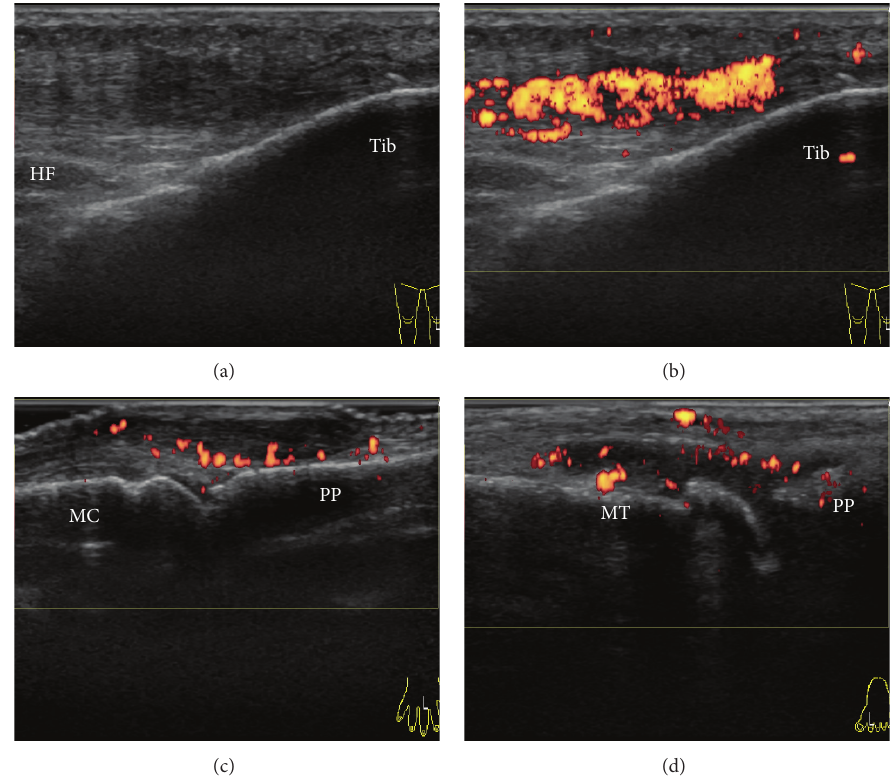
Figure 3: Ultrasound findings of knees, fingers, and toes. (a) Gray-scale and (b) power Doppler ultrasonograms of the longitudinal scan of the distal right patellar tendon (PT). Similar findings were also observed in the left PT (not shown). (c) Power Doppler ultrasonograms of the longitudinal scan of the extensor tendon and metacarpophalangeal joint of the third finger of the left hand. (d) Power Doppler ultrasonograms of the longitudinal scan of the metatarsophalangeal joint of the second toe of the left foot. HF Hoffa’s fat pad, Tib Tibia, MC metacarpal bone, PP proximal phalange, MT metatarsal bone.